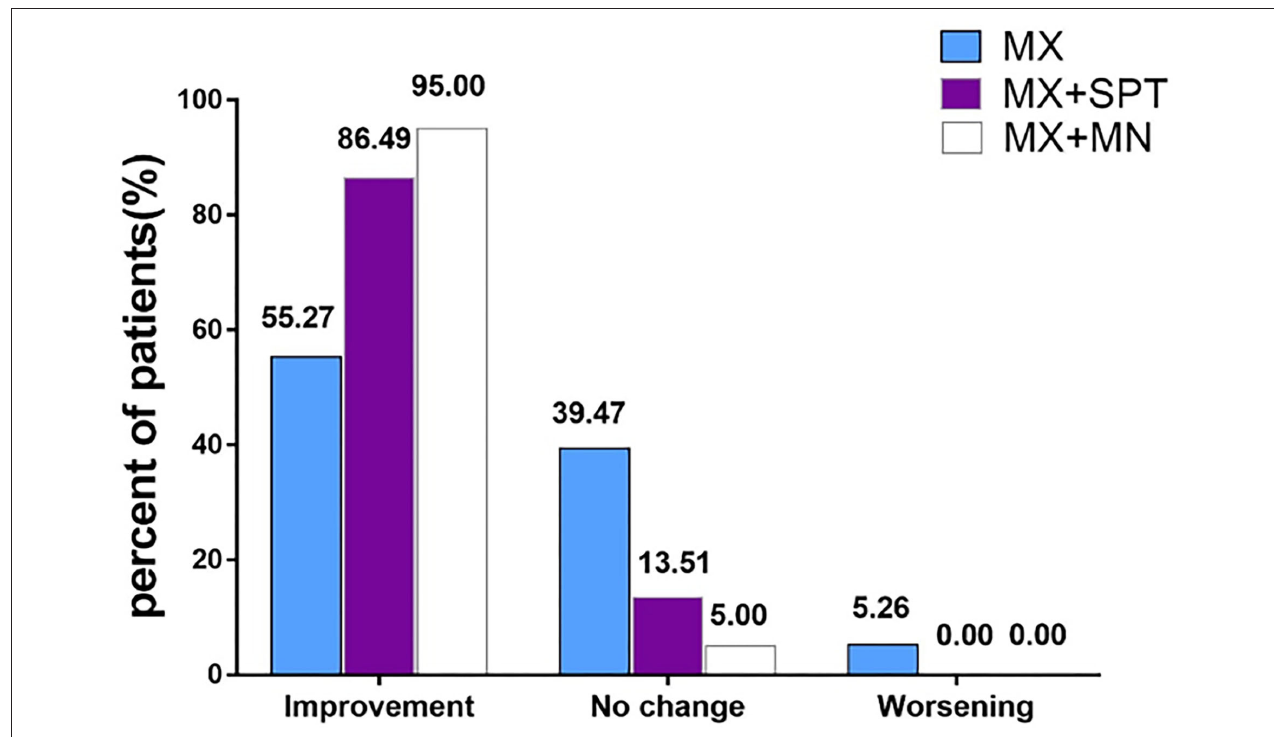
FIGURE 4 | Physician’s global photographic assessment based on a standardized 7-point scale at week 24. MX, minoxidil; SPT, spironolactone; MN, microneedling.